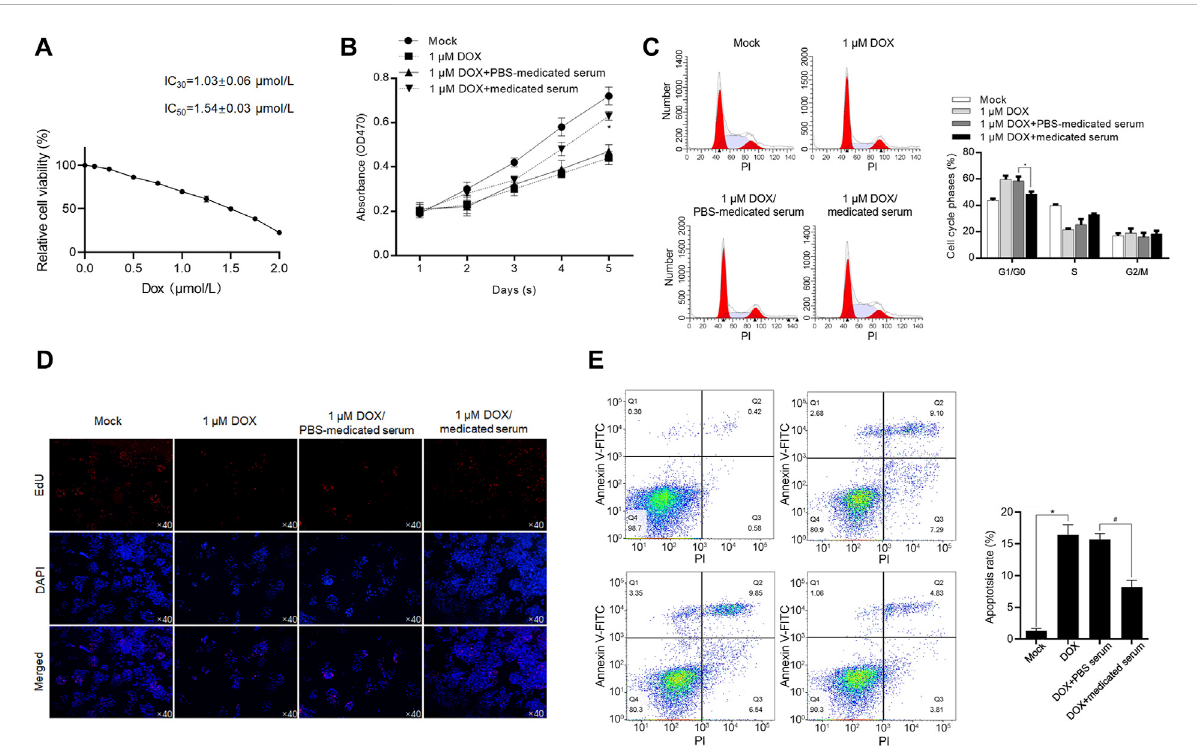
FIGURE 4 YXX keli protects RCM against DOX-induced cell injury. (A) . After 24-h incubation under a range concentration of DOX, the cell viability of H9c2 was measured by performing a CCK-8 assay. After the addition of medicated serum for co-incubation with 1 μ M of DOX for 24 h, cell viability was measured by performing CCK-8 assay (B) , cell cycle distribution was measured by performing PI staining followed by fl ow cytometry (C) and proliferating cells were stained using EdU assay (D) . * p < 0.05, vs. 1 μ M DOX + PBS-medicated serum group. (E) After the addition of medicated serum for co-incubation with 1.54 μ M of DOX for 24 h, cell apoptosis was measured by performing Annexin V-FITC/PI double staining followed by fl ow cytometry assay. * p < 0.05, mock group; # p < 0.05, DOX + PBS-medicated